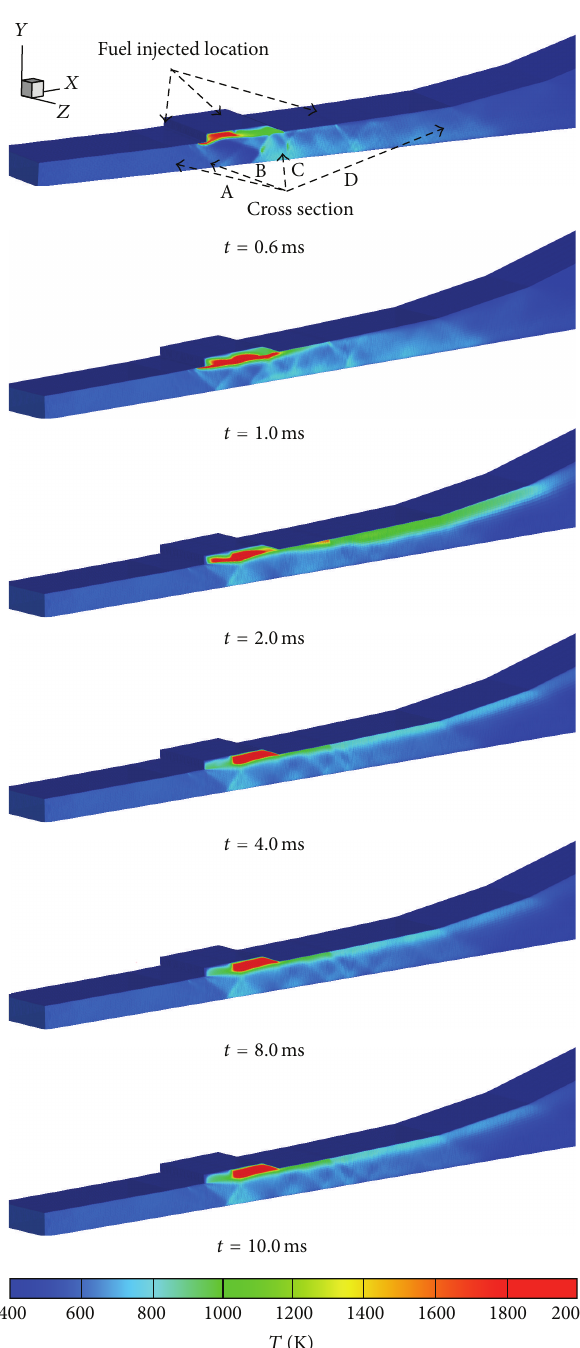
Figure 8: Evolution of the temperature field in the scramjet com- bustor during the ignition transient without air